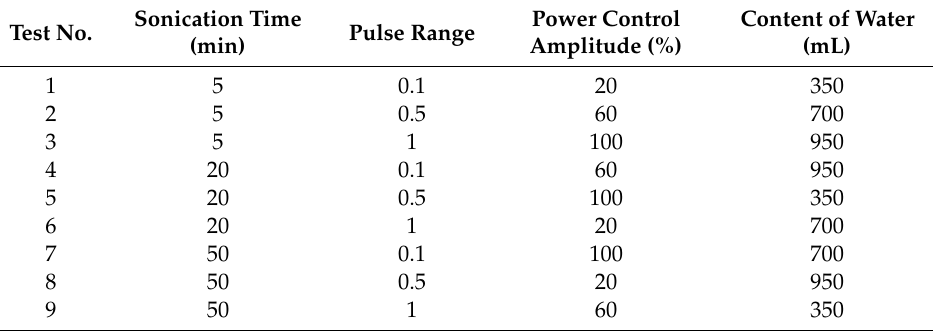
Table 6. The experimental layout according to the L9 orthogonal